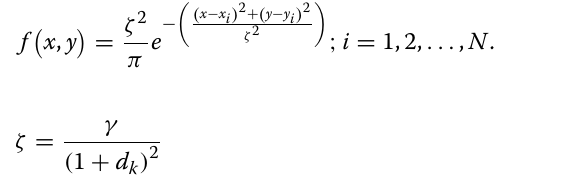
Scheme 2 : To better detect the outliers, a better function